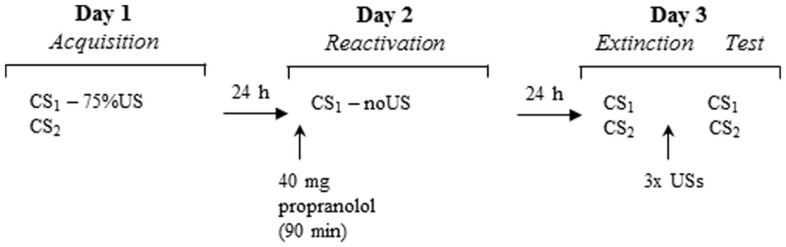
Schematic of the experimental design over three days.